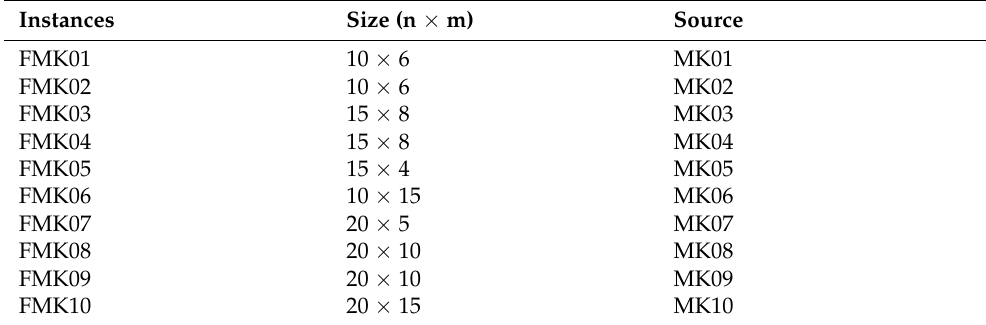
Table 1. Composition of the instances.